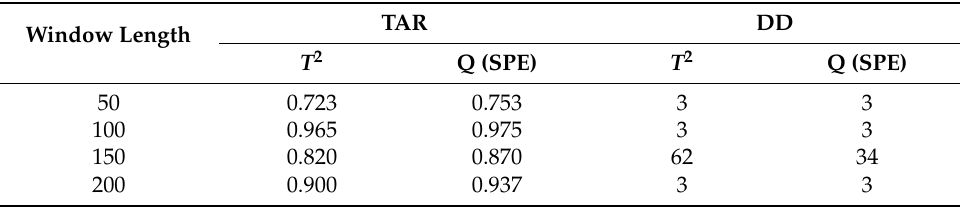
Table 9. Monitoring AG mill operational state using Method I.